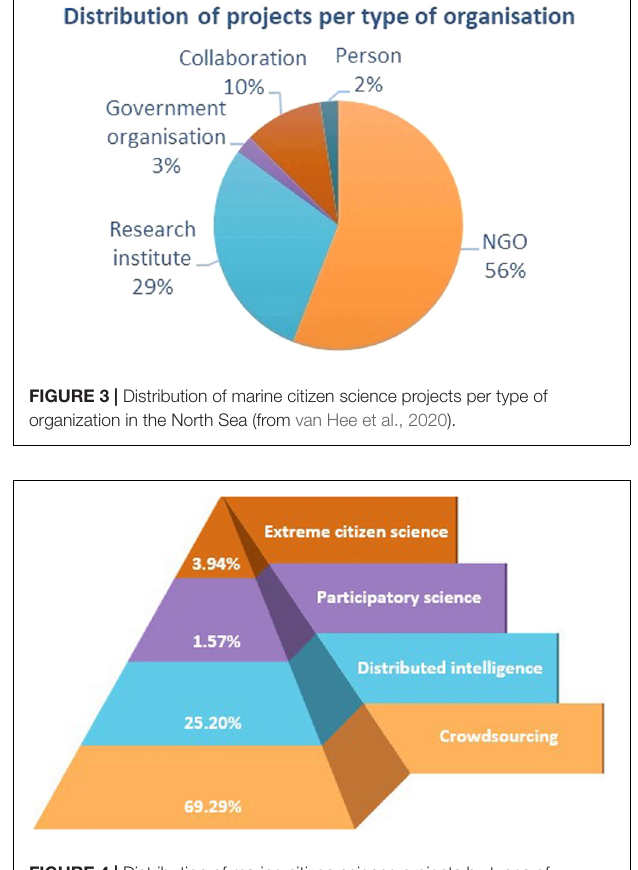
FIGURE 4 | Distribution of marine citizen science projects by types of participation in the North Sea (from van Hee et al.,